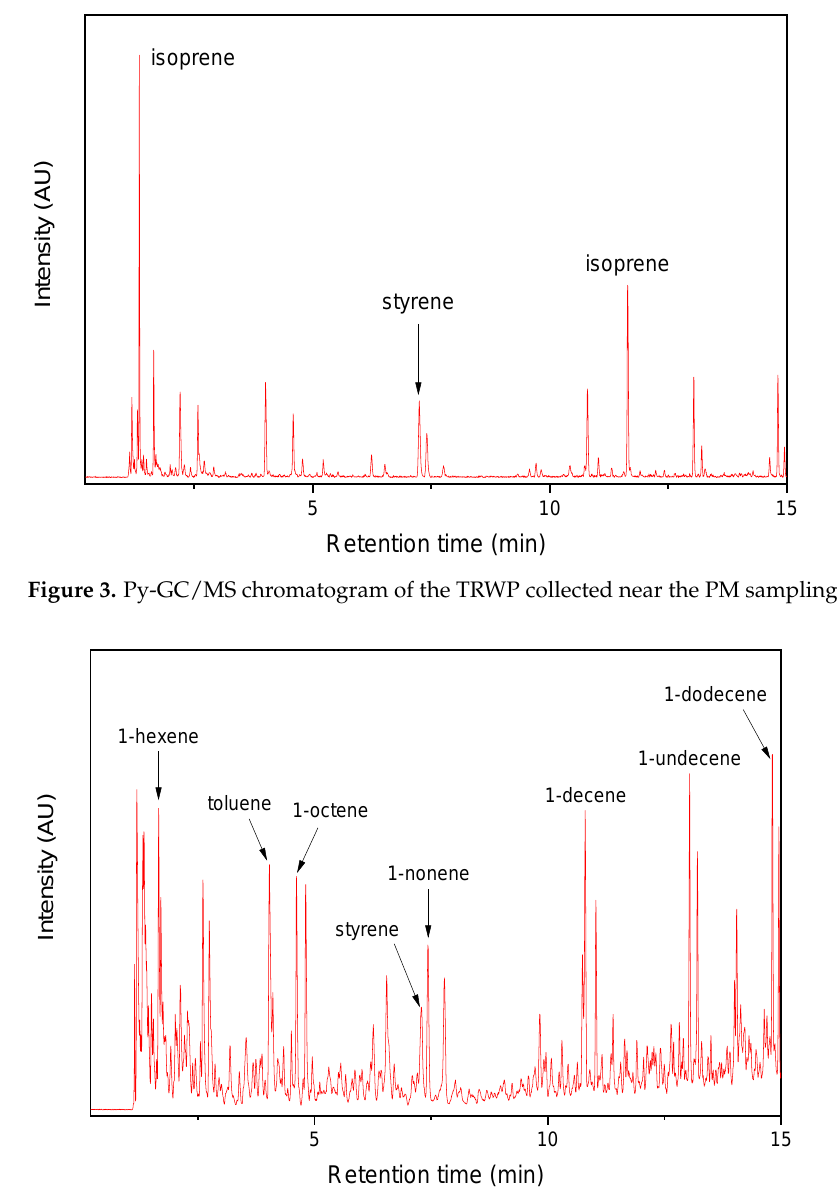
Figure 4. Py-GC/MS chromatogram of the AWP collected near the PM sampling site.